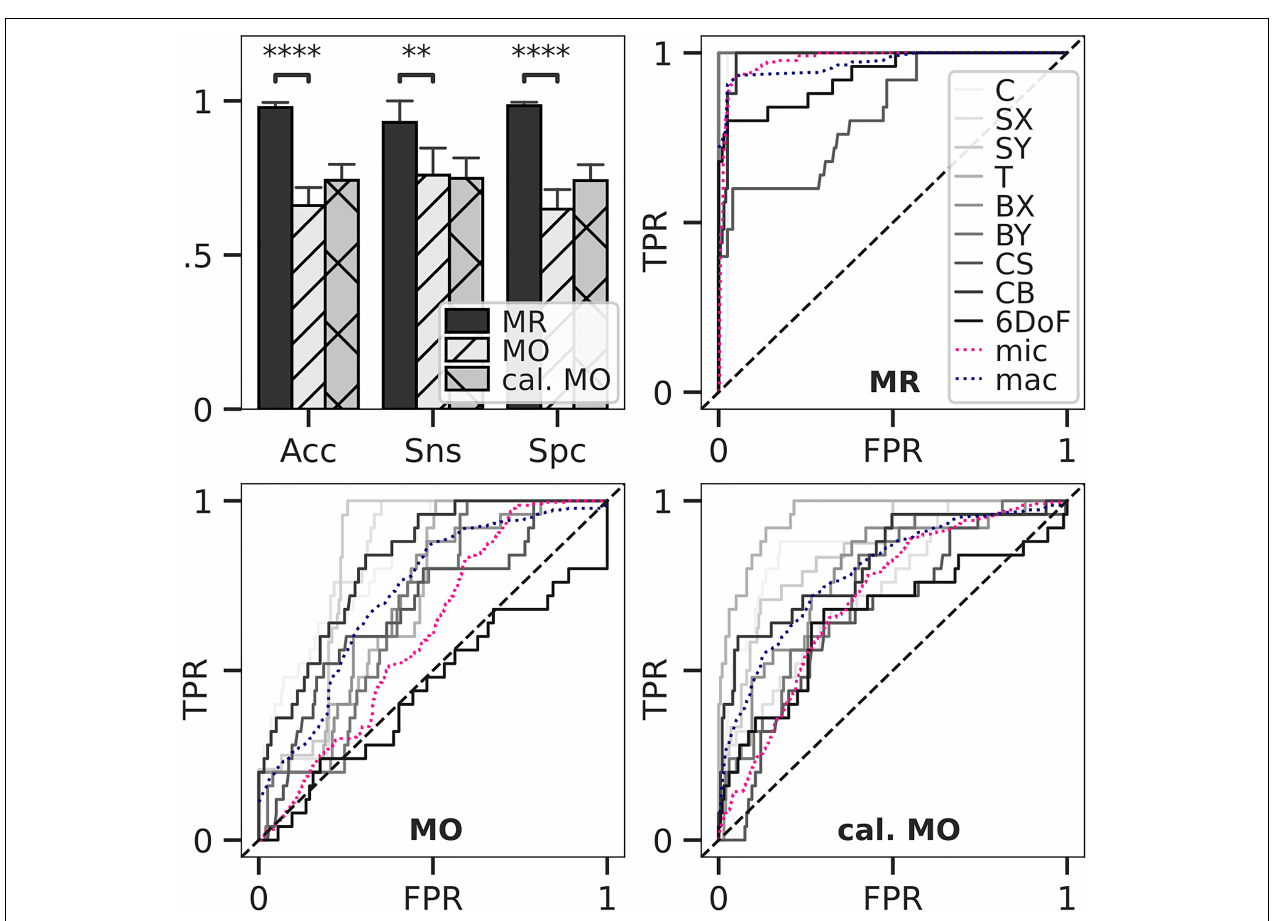
FIGURE 4 | Classification accuracy and ROC for load estimation. Loads of in silico -adapted bone geometries ( n = 5) with nine different loading boundary conditions were estimated and compared to the simulated target load serving as ground truth. Accuracy, sensitivity, and specificity for estimated optimal thresholds were calculated (upper left). Bars show mean, and error bars show 95% confidence interval. All differences between means with p < 0.05 are indicated ( ∗∗ p < 0.01; ∗∗∗∗ p < 0.0001; two-tailed paired t -test). Thresholds were derived from multiclass receiver operating characteristic (ROC) for mechanoregulation-based load estimation (MR, upper right), load history LH (lower left), and calibrated LH (lower